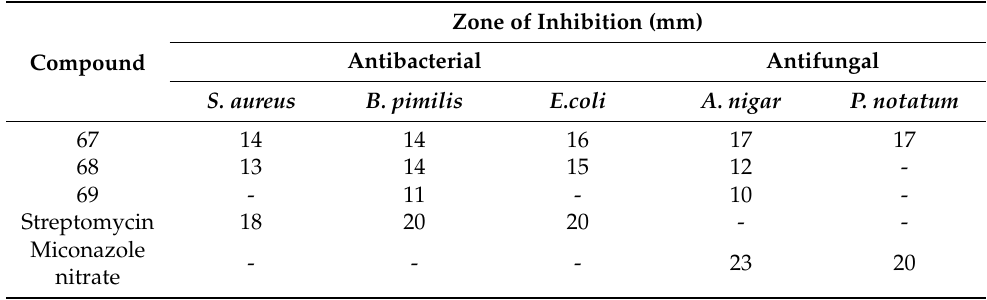
Table 4. Antimicrobial activity of quinoxaline-substituted benzene sulfonamide derivatives 67 – 69 .